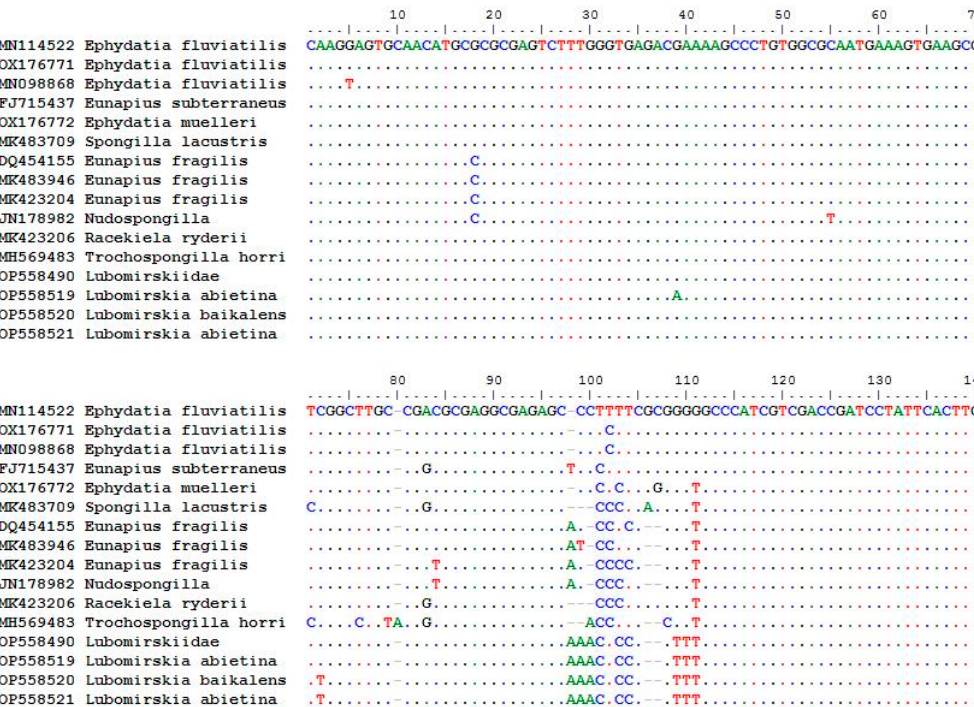
Figure 3. Fragment of alignment of 28S rDNA D3 region sequences of Spongillida before exclusion of regions that are not unambiguously alignable. Dots indicate identity with the first sequence, and dashes are inferred insertion–deletion.